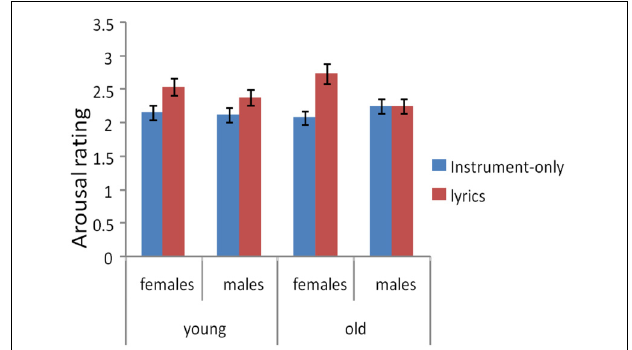
FIGURE 2 | Three-way interaction between vocals, sex, and age on arousal